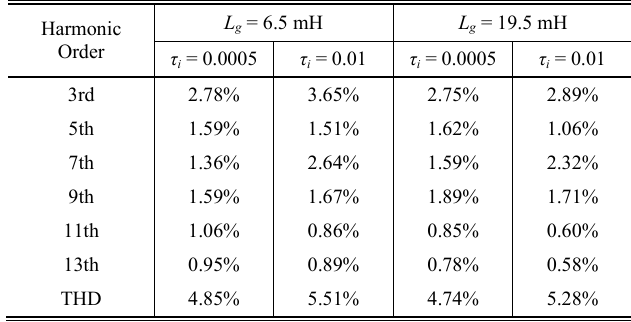
Fig. 20. Output voltage and output current when L g = 19.5 mH ( k p = 3)